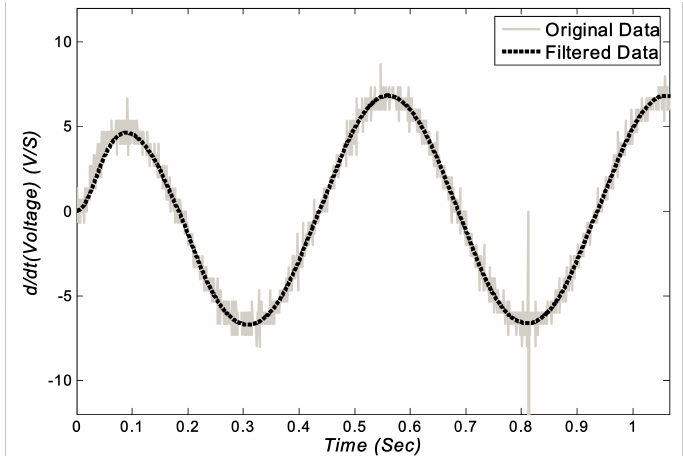
Figure 18. Comparison of the original and filtered feedback voltages of the actuator’s LVDT for Amp = 20 mm and Freq = 2 Hz.